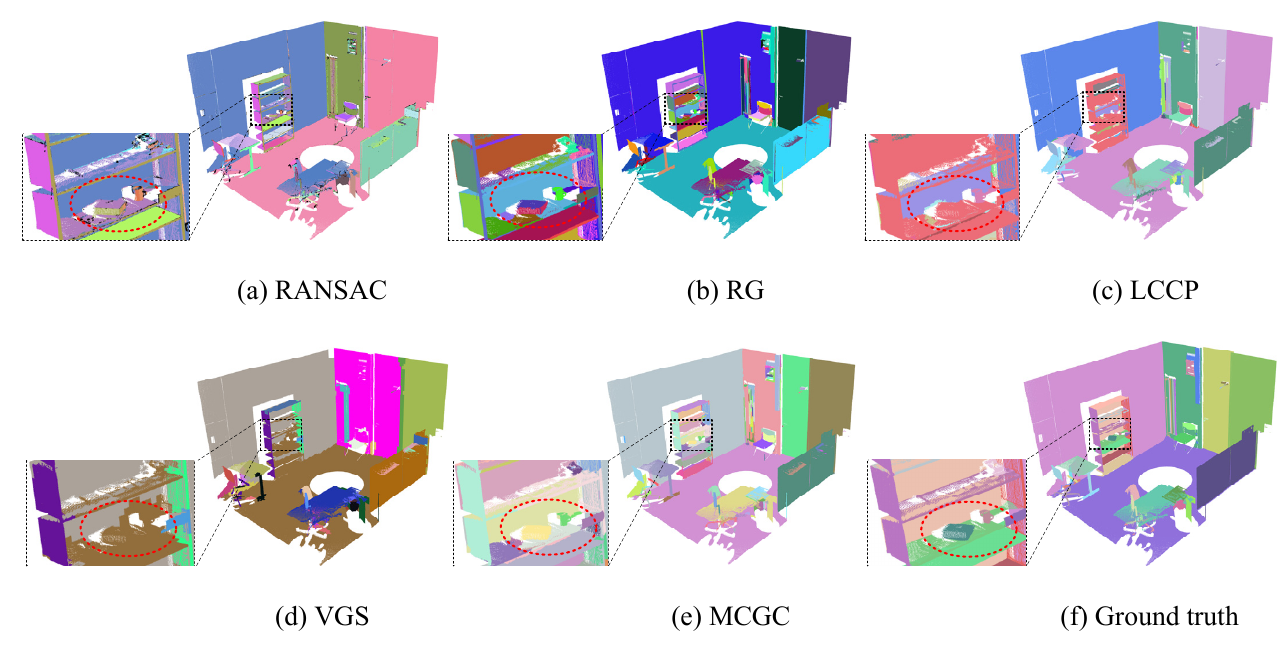
Figure 12. The visual comparison of the Room-L9 by different methods. One local scene slice which is selected to enlarge the segments in the black box. ( a ) The result from RANSAC. ( b ) The result from RG. ( c ) The result from LCCP. ( d ) The result from VGS. ( e ) The result from MCGC. ( f ) The ground truth.